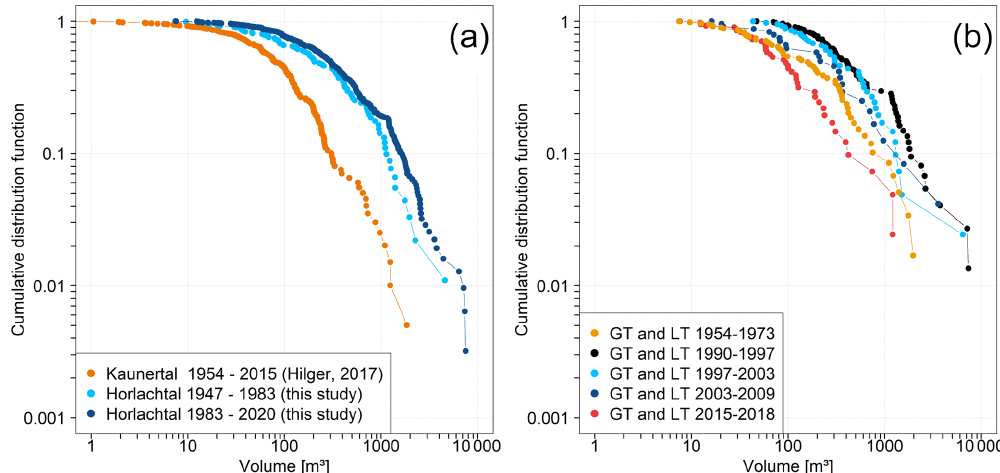
Figure 11. (a) Magnitude–frequency relationship for the early debris flows in Horlachtal (1947–1983, light blue) compared with recent debris flows (1983–2020, dark blue). The results of a similar investigation from Hilger (2017) in Kaunertal are shown in orange. (b) Comparison of the magnitude–frequency relationships of different periods in GT and